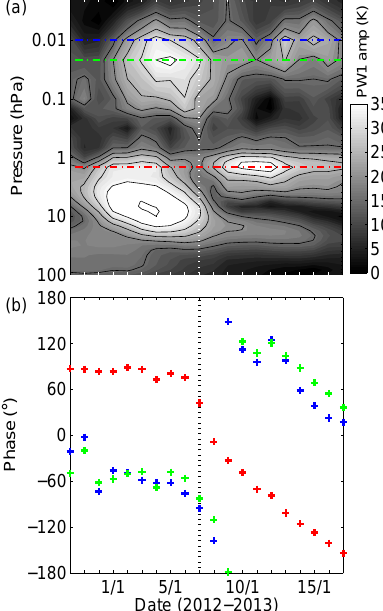
Figure 5. Planetary wave-1 amplitude (in K) from 29 December until 17 January. Contours highlight the 15 to 45K levels, with in- tervals of 5K. Dash-dotted lines indicate (from top to bottom) the 0.01hPa (blue), 0.02hPa (green) and 1.5hPa (red) level. (b) Plan- etary wave-1 phase (longitude ( ◦ ) of maximum temperature) at 0.01hPa (blue crosses), 0.02hPa (green crosses) and 1.5hPa (red crosses). The onset of the SSW is indicated by a dotted line in both